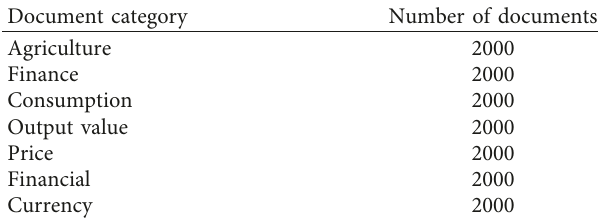
Table 1: Basic information of the original corpus.